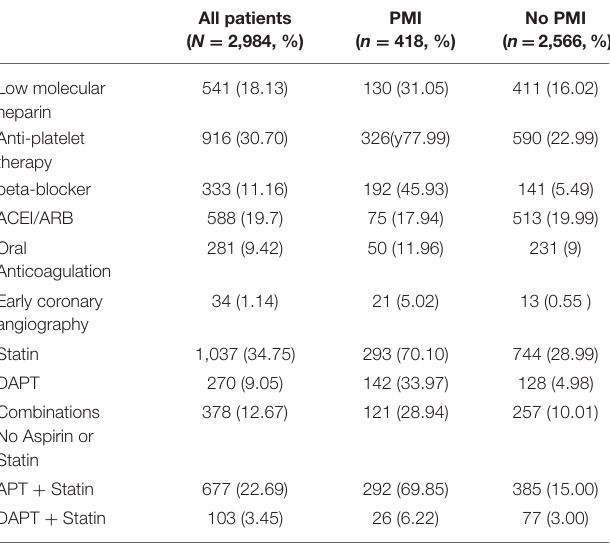
TABLE 5 | Perioperative medical therapy in patients with and without PIM.